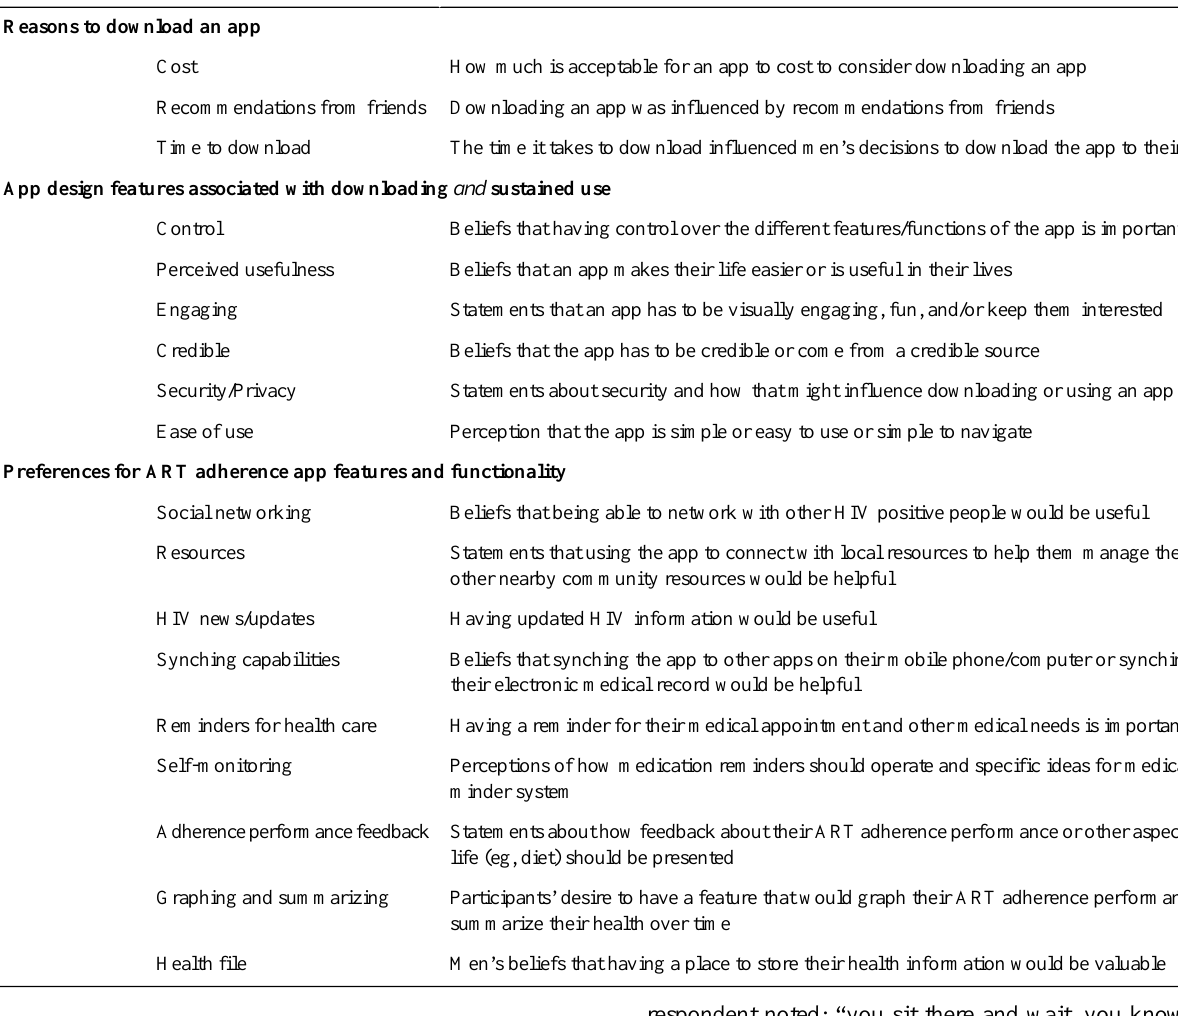
Table 3. Themes and definitions. DefinitionTheme Reasons to download an